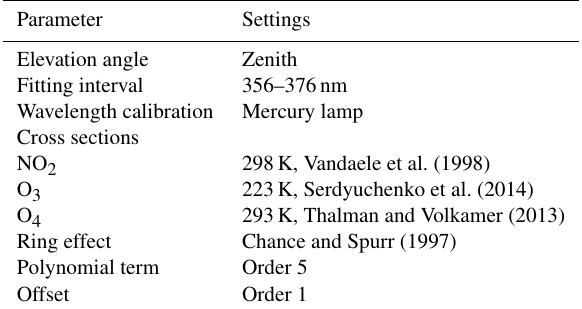
Table 5. Properties of the mobile DOAS system and its NO 2